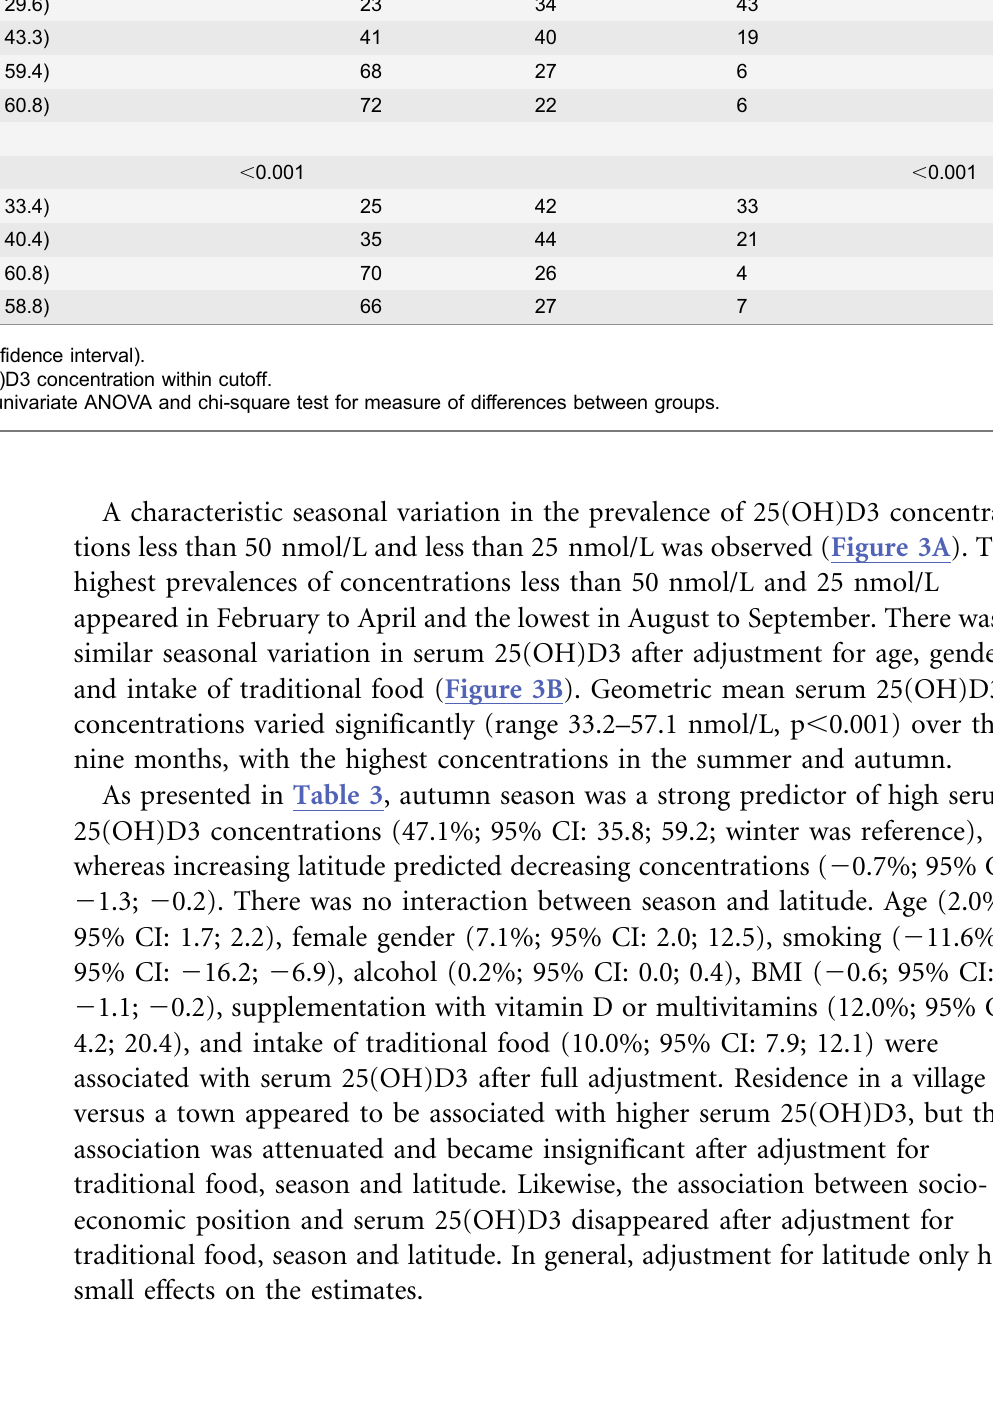
Table 2. Serum 25(OH)D3 (nmol/L) and prevalence of concentrations above 50 nmol/L, 25–50 nmol/L and less than 25 nmol/L among 2877 individuals included in the IHIT-study, 2005–2010, by gender and age